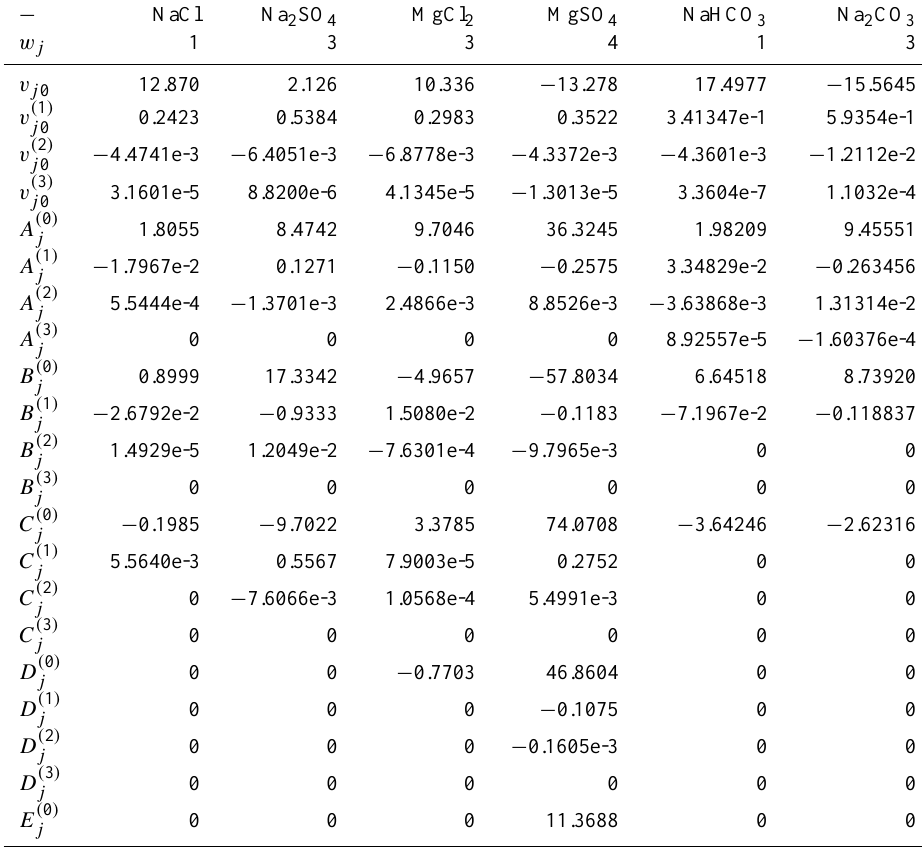
Table 2. Parameters from Eq. (14) for apparent molal volumes (cm 3 mol − 1 ) of binary electrolytes for temperatures 0 ◦ C to 50 ◦ C. These = I 0 /w j . Sources are: NaCl, Na equations are in terms of molalities c 0 2 SO 4 , MgCl 2 , MgSO 4 – Lo Surdo et al. (1982), NaHCO 3 and j Na 2 CO 3 – Hershey et al. (1983), NaB ( OH ) 4 , B ( OH ) 3 – Ward and Millero (1974), KCl, CaCl 2 – equations fit to model output of Mao